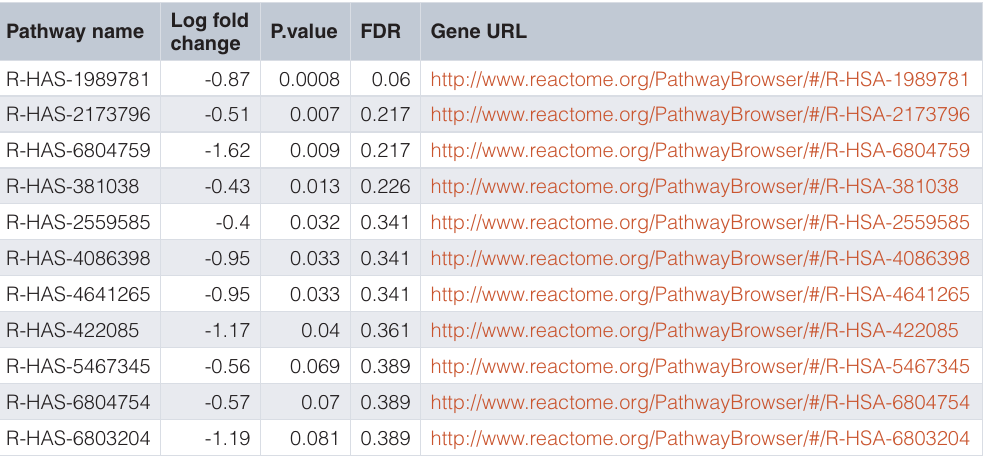
Table 1. Arkas-Analysis Gene-Set Enrichment Statistics. The columns represent the Reactome pathway name corresponding to the depicted pathways in Figure 4, the log active link to the Reactome website with visual depictions of the gene/transcript pathway. Arkas-Analysis will output a similar report testing transcript-level